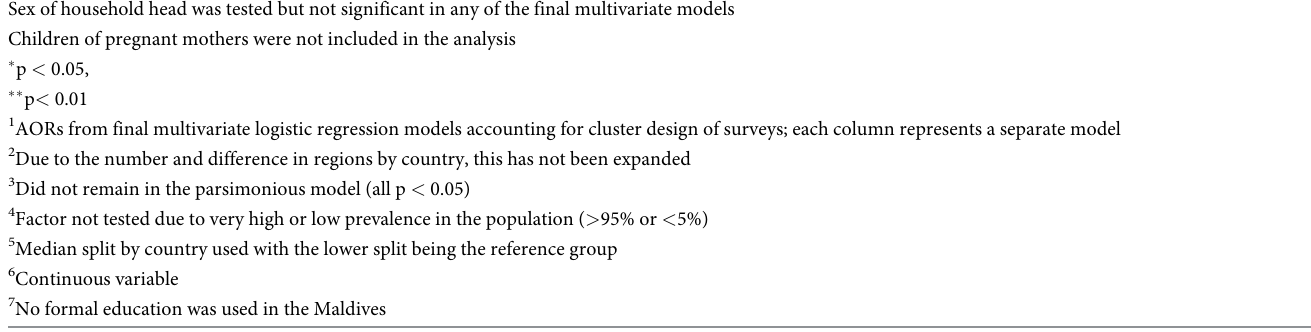
n in model % wasted Variable Environmental Region 2 Rainy Season Household Wealth (Ref richest) Richer Middle Poorer — — Poorest — Improved water (lacking) — Improved sanitation (lacking) Household size 5 Husband has no formal educ NA Mother Age [y]